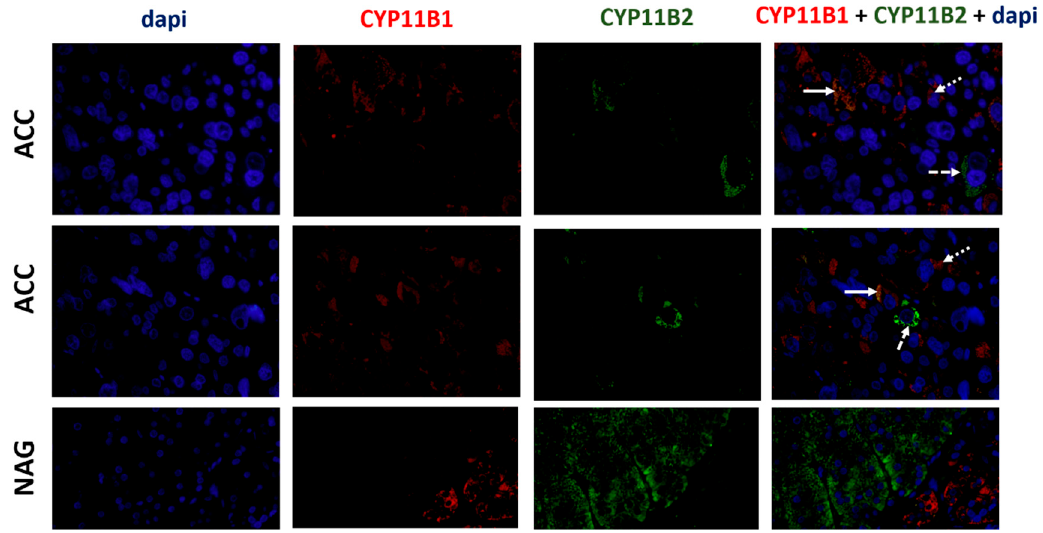
Figure 7. Immunofluorescence staining for CYP11B1 (red), CYP11B1 (green), and dapi (blue) in adrenocortical carcinomas (ACC) and normal adrenal gland (NAG) (400×). Solid arrows indicate cells co-staining for CYP11B1 and CYP11B2, dotted arrows indicate examples of cells only staining for CYP11B1, and dashed arrows indicate examples of cells only staining for CYP11B2, in ACC.